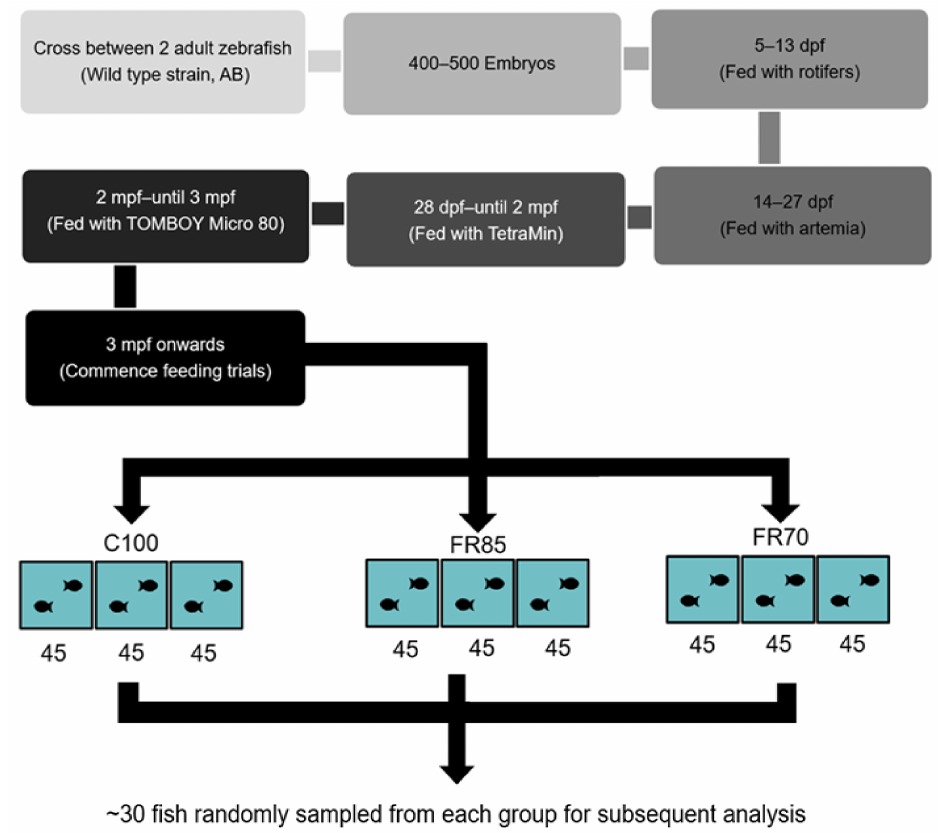
Figure 1. Flow chart outlining the experimental design for assessing the effect of feed restriction on zebrafish. Abbreviations: dpf: days-post-fertilization; mpf: months-post-fertilization; C100, FR85, and FR70 refer to feeding the fish to 100%, 85%, and 70% satiety, respectively; 45 refers to the number of zebrafish stocked in each experimental tank. Approximately 30 fish were sampled each week for